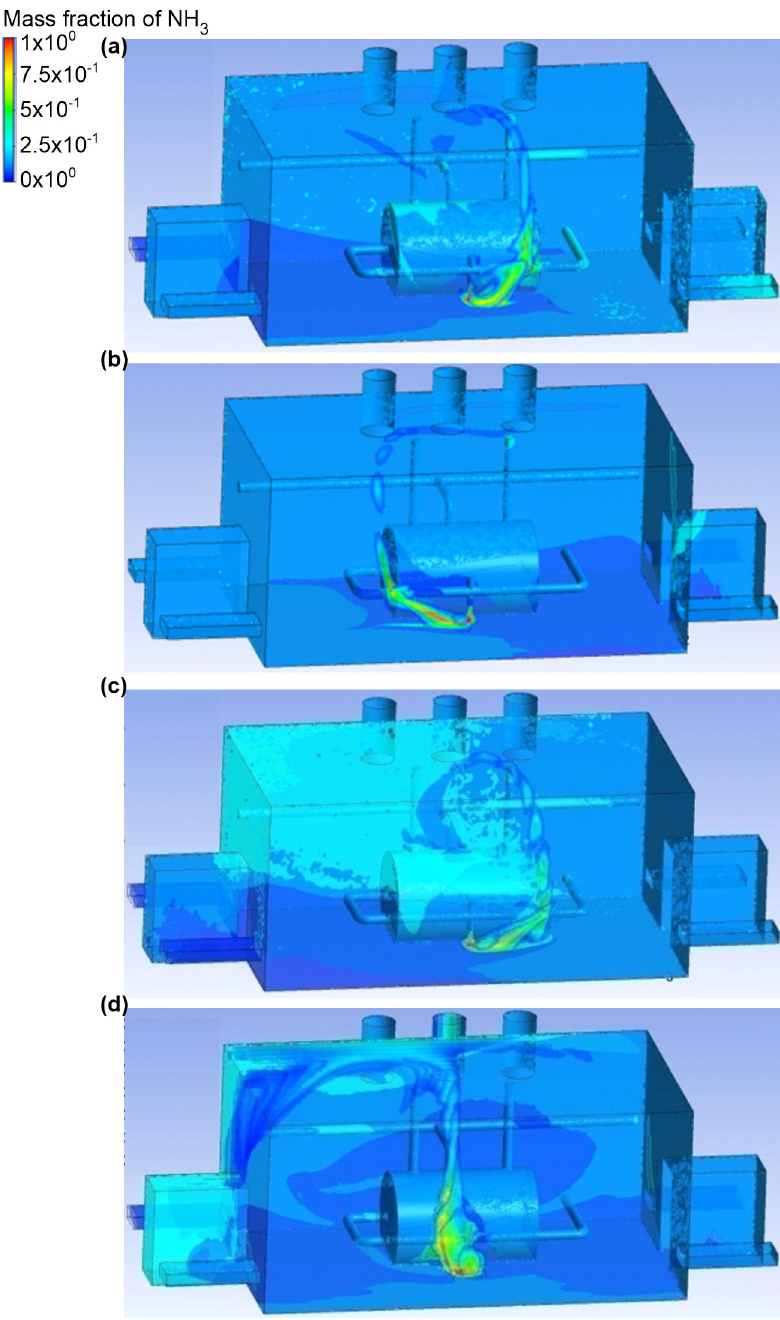
Figure 8. Ammonia distribution in the engine room for: ( a ) scenario A, ( b ) scenario B, ( c ) scenario C, and ( d ) scenario D.